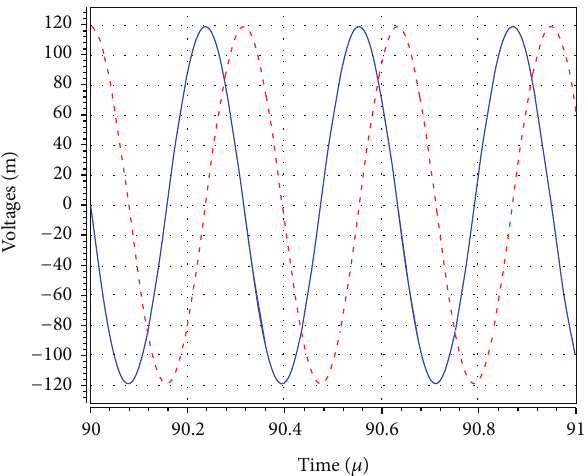
Figure 5: Transient amplitudes of the waveforms of 𝑉 𝑜1 (blue) and 𝑉 𝑜2 (red).